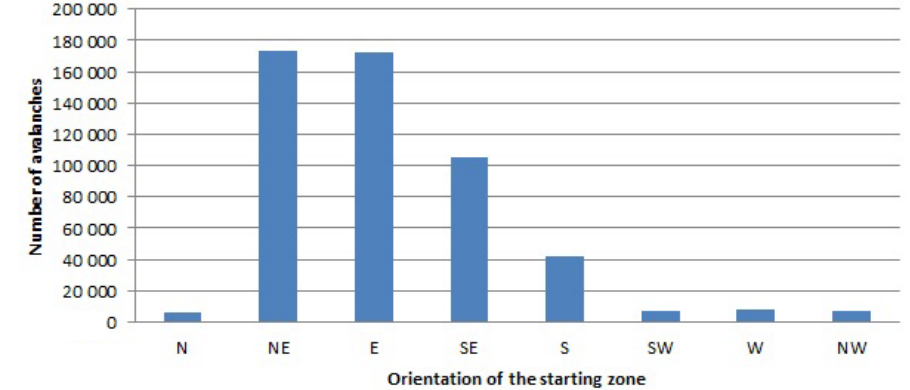
Figure 6. Number of avalanches as a function of orientation of the starting zone. Only the 520 avalanches that could be precisely located are